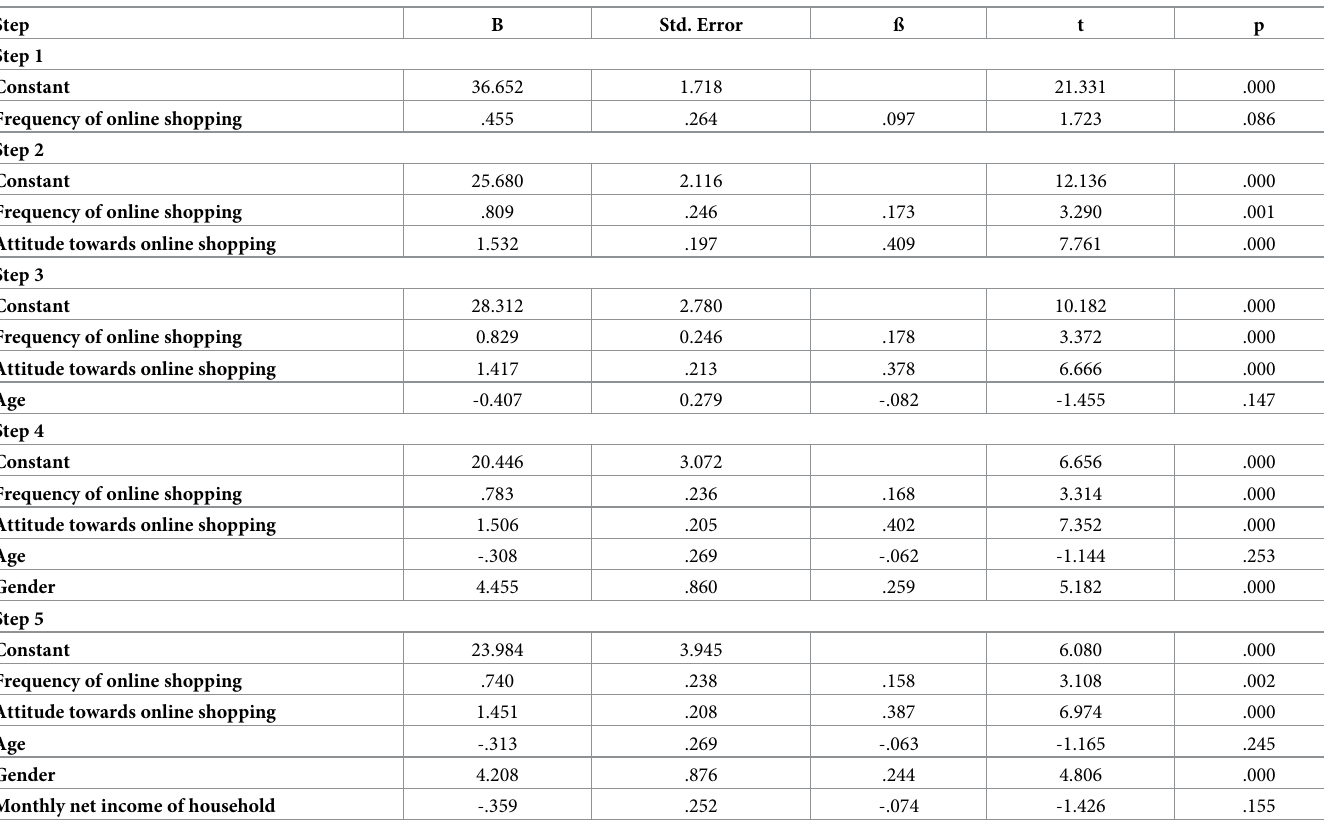
Table 5. Summary of the stepwise regression analysis of frequency of shopping online, attitudes towards shopping online, age, gender, and monthly net income of household as predictors of compulsive buying. B Std. Error